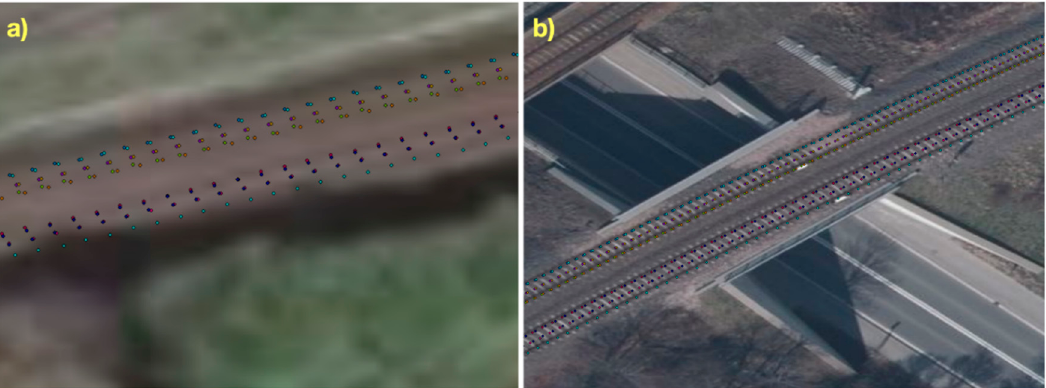
Figure 9. Sections of the railway route: ( a )—near the locality of Czarna Woda, ( b )—in an urbanised area in the town of Tczew.